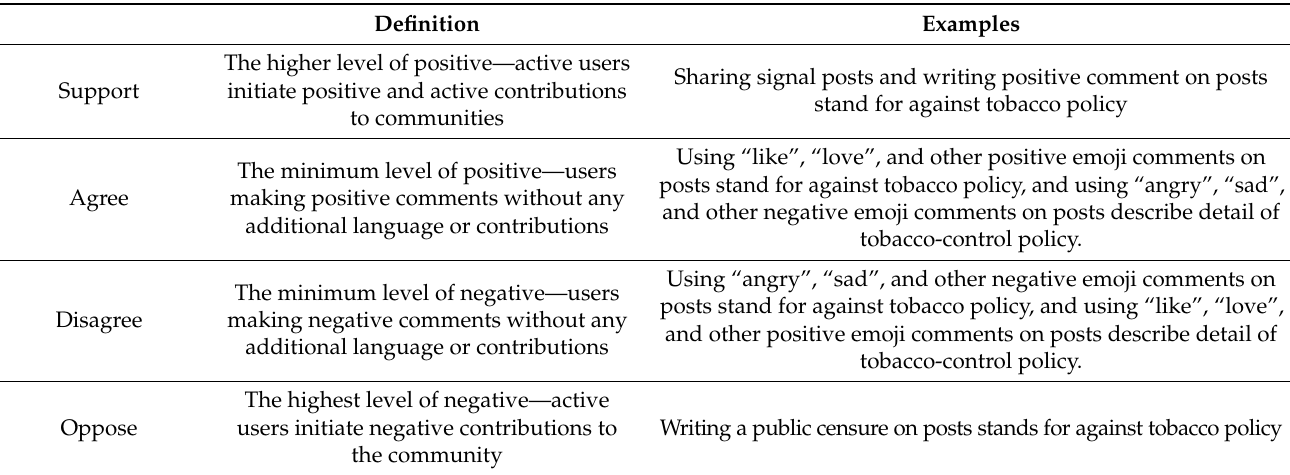
Table 1. Facebook members engagement behavior